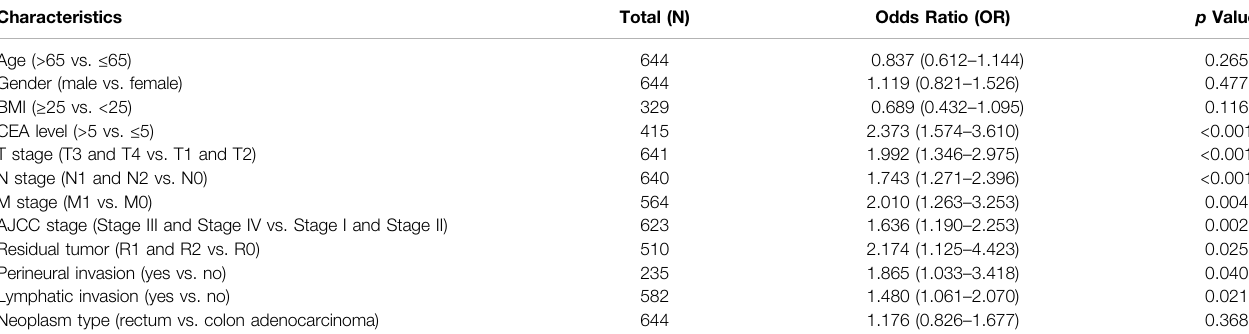
TABLE 1 | Clinicopathological factors and FCRLB expression in the TCGA CRC cohort. Characteristics